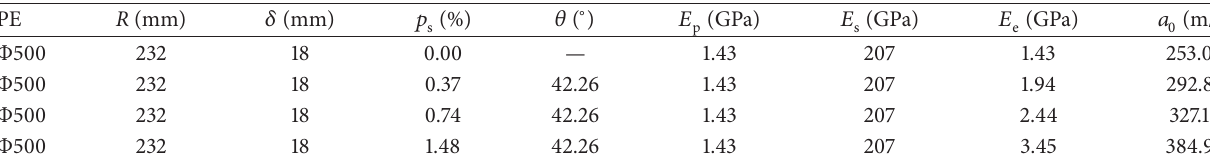
Table 2: Wave speeds of PE pipes with various reinforcement ratios.